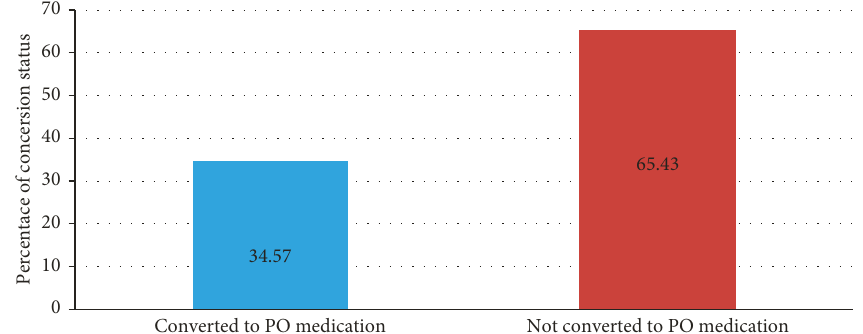
Figure 2: Intravenous to per oral conversation practices at the University of Gondar Comprehensive and Specialized Hospital from October 3 to November 14, 2021 ( n � 324).